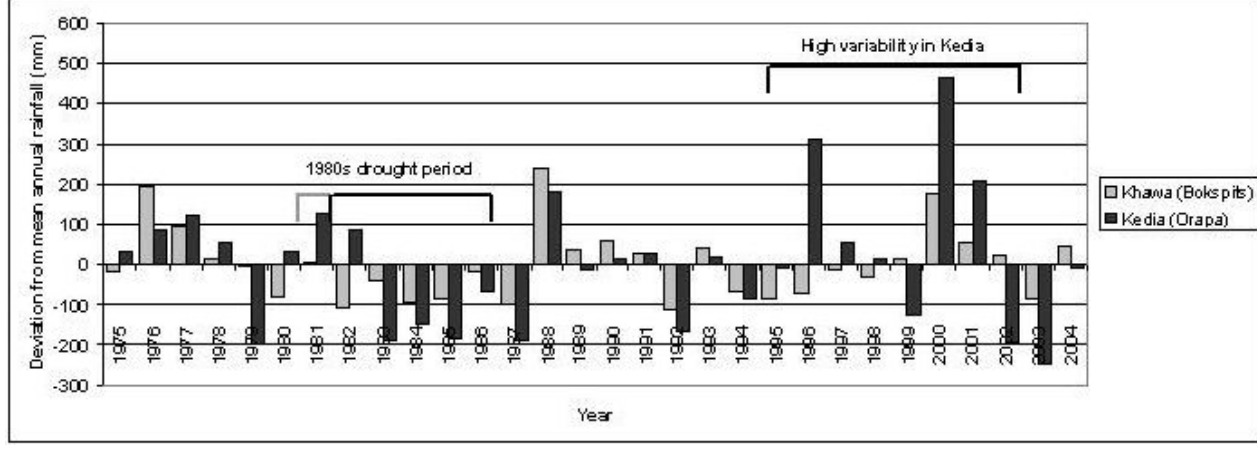
Fig. 2 . Rainfall variability in Khawa and Kedia between 1975 and 2004 as illustrated by deviations from mean annual rainfall. The 1980s drought period is evident from the recurrent and prolonged period of below average rainfall. Data from nearest weather stations – Bokspits (100 km southwest of Khawa) and Orapa (55 km east of Kedia) – are presented. (Data source: Department of Meteorological